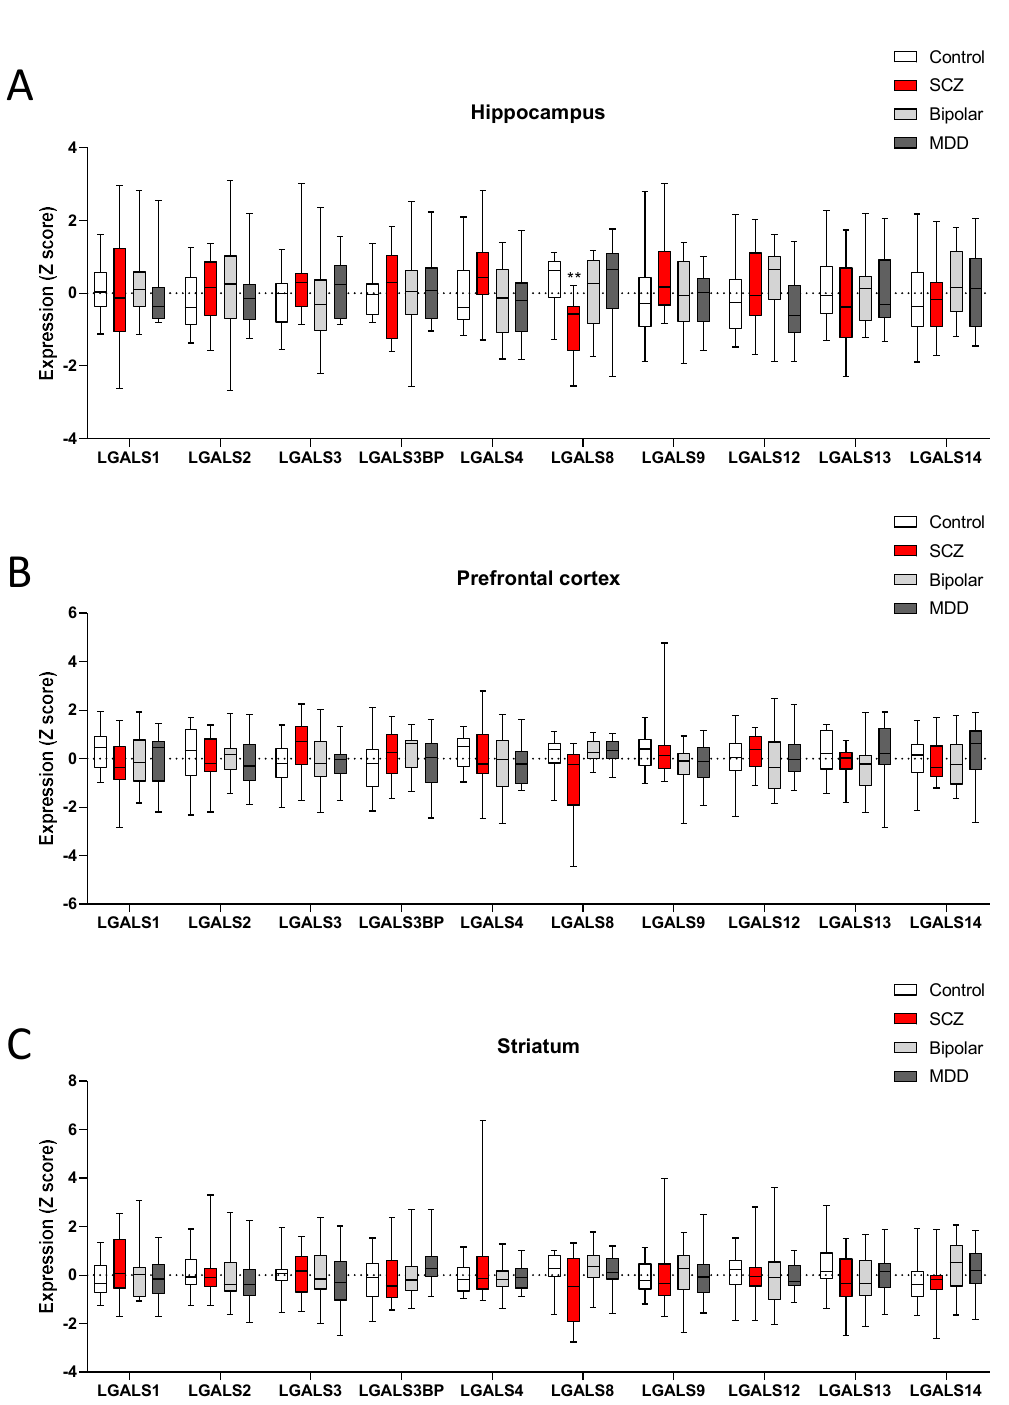
Figure 2. Expression levels of galectin gene family members in the SCZ brain. The expression levels of the members of the galectin gene family were determined by interrogating the GSE53987 dataset. ( A ) Expression levels of the galectin genes in post-mortem samples of the hippocampus from control donors, and SCZ, bipolar, and MDD patients. ( B ) Expression levels of the galectin genes in post-mortem samples of the prefrontal cortex from control donors, and SCZ, bipolar, and MDD patients. ( C ) Expression levels of the galectin genes in post-mortem samples of the striatum from control donors, and SCZ, bipolar, and MDD patients.